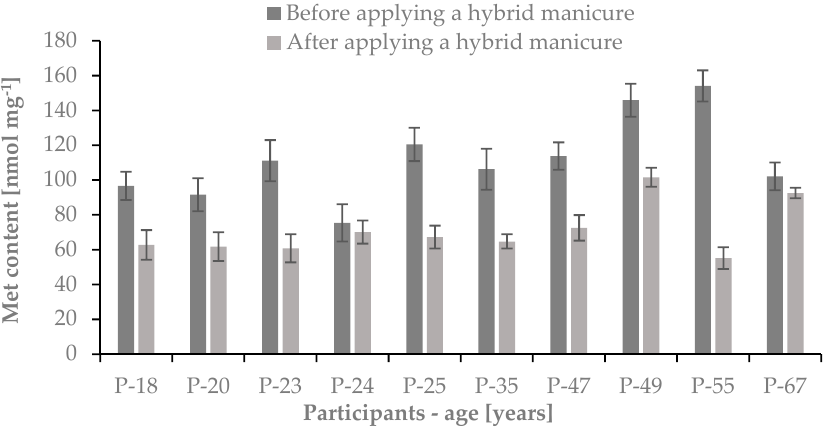
Figure 9. The Met content in the nail plates of studied women before and after the use of hybrid manicure; n = 3.